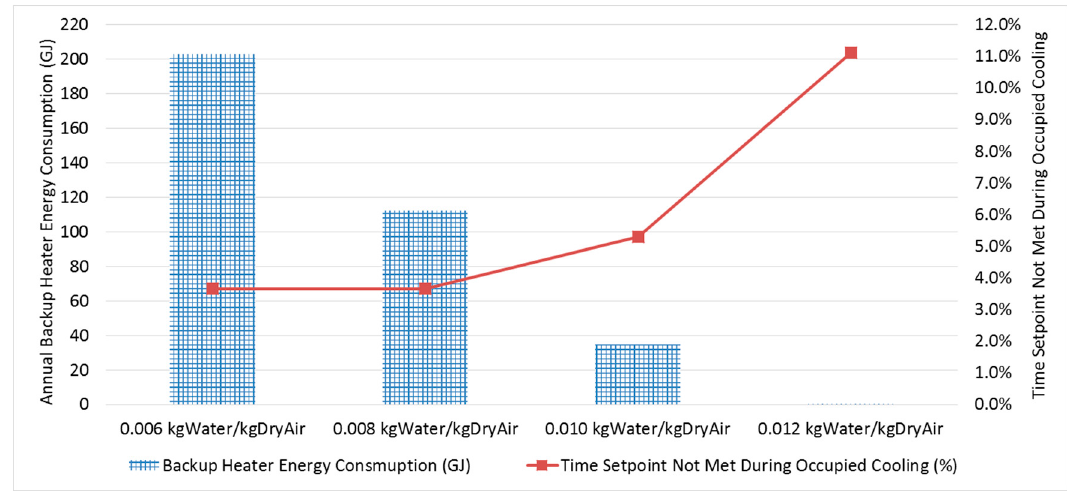
Figure 17. The impact of the outdoor air humidity ratio control on backup heater energy consumption and indoor thermal conditions. and indoor thermal